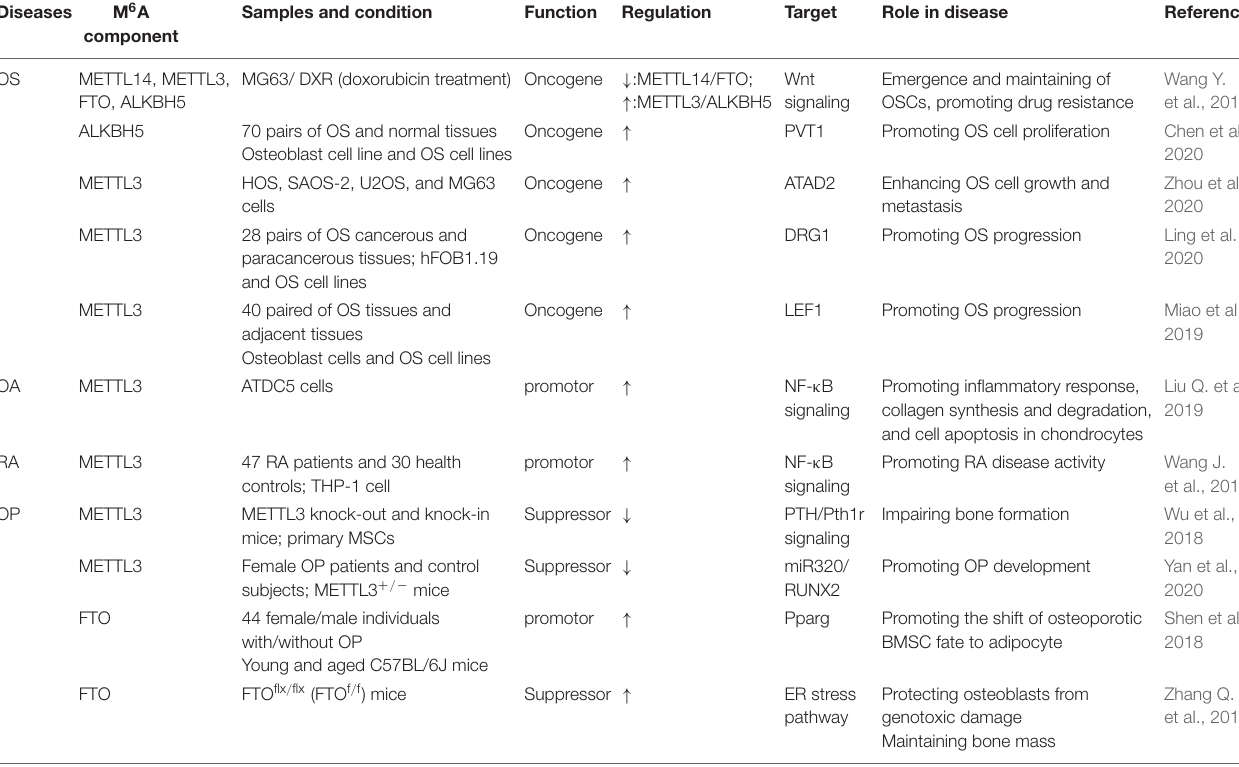
TABLE 2 | The role of m 6 A in musculoskeletal